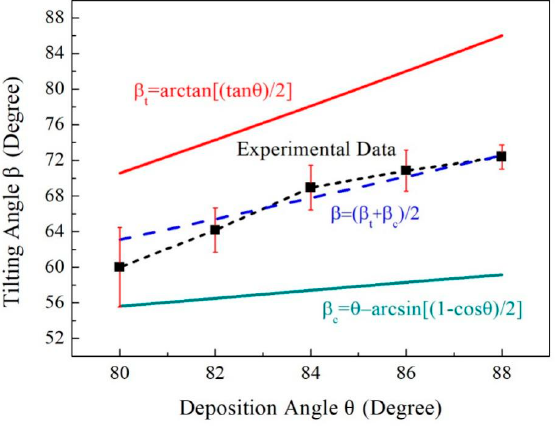
Figure 7. The Au nanorod tilting angle β as a function of deposition angle θ .